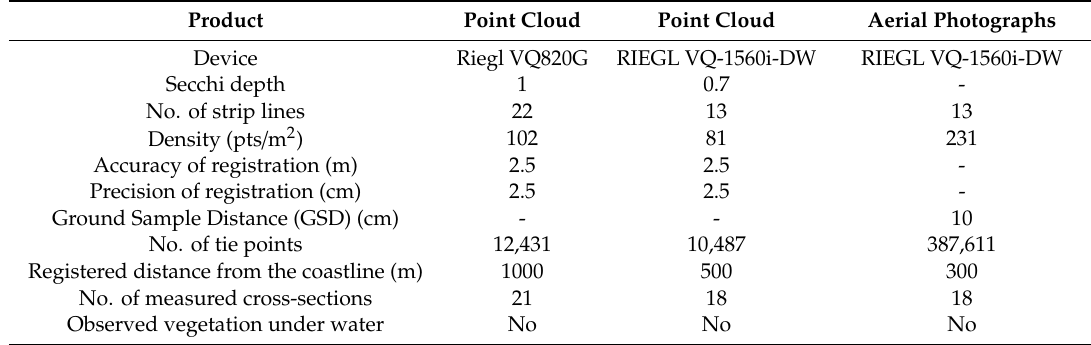
Table 3. System details for laser scanning and aerial photogrammetric devices used in the experiment. Product Aerial